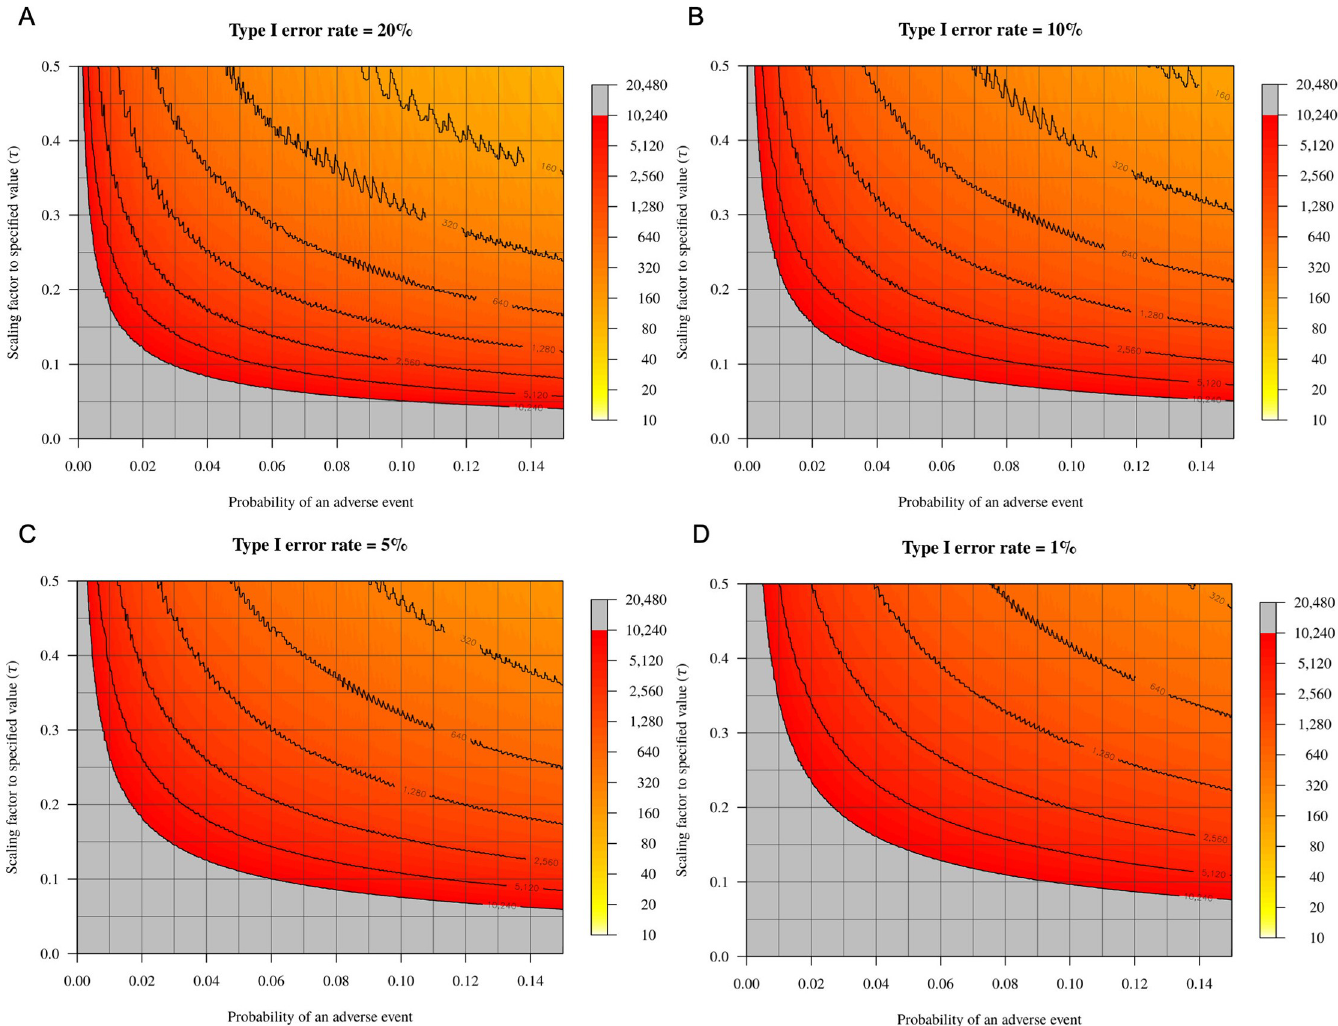
Fig 5. Heat maps illustrating the relationship between the probability of an adverse event ( x -axis), the scaling factor to specified value ( y -axis), and the required sample size (yellow-grey gradient) for different Type I error rates (1–20%; a–d). For a given probability of an adverse event, larger sample sizes are required with low Type I error rates and at low scaling factors. The sample size is given up to a maximum of 10,240; larger sample sizes are required for the grey-coloured